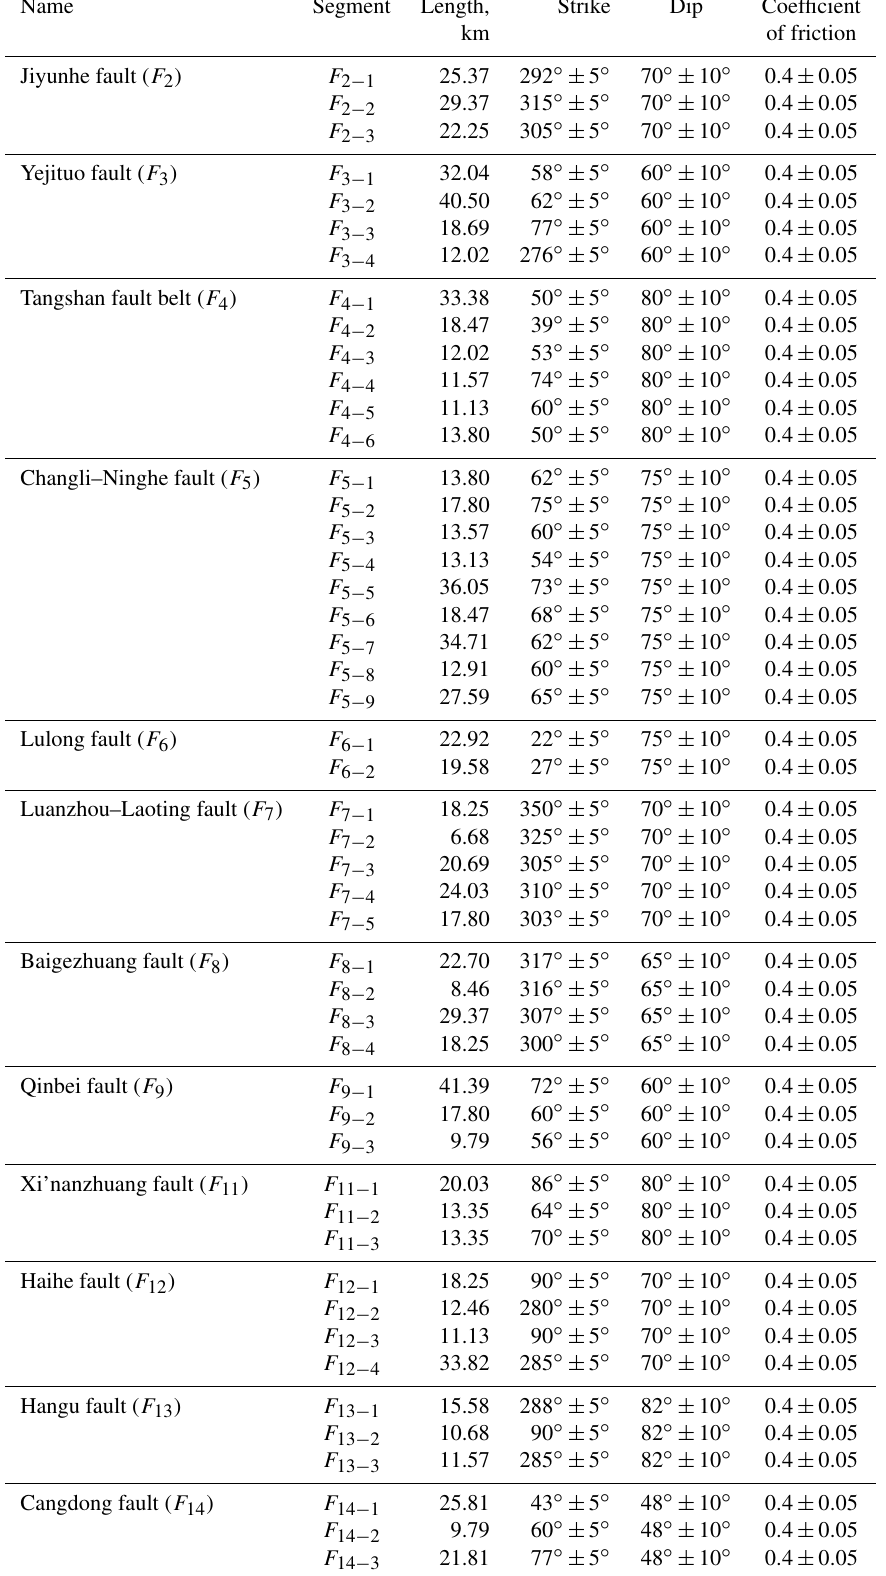
Table 4. The geological information of the main active faults used for calculating probabilistic fault slip potential in the Tangshan seismic